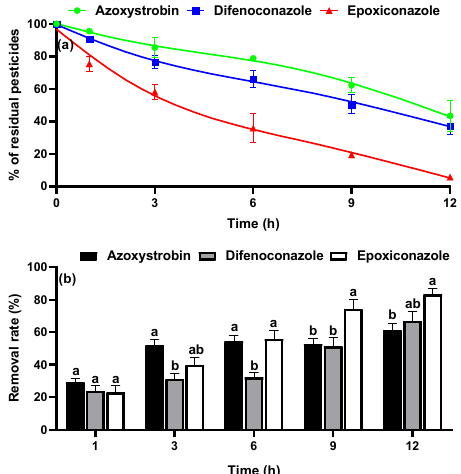
Figure 5. Elimination of the three pesticides during the first drying process. E ff ects of drying temperatures on the levels of pesticide residues in P. Radix at two times the recommended dosage and the removal of the three pesticides at the same temperature (40 ◦ C) for treatment with pesticide concentrations of five times the recommended dosage. Di ff erent lowercase letters at the top of columns represent significant di ff erences in residue levels at a p -value of